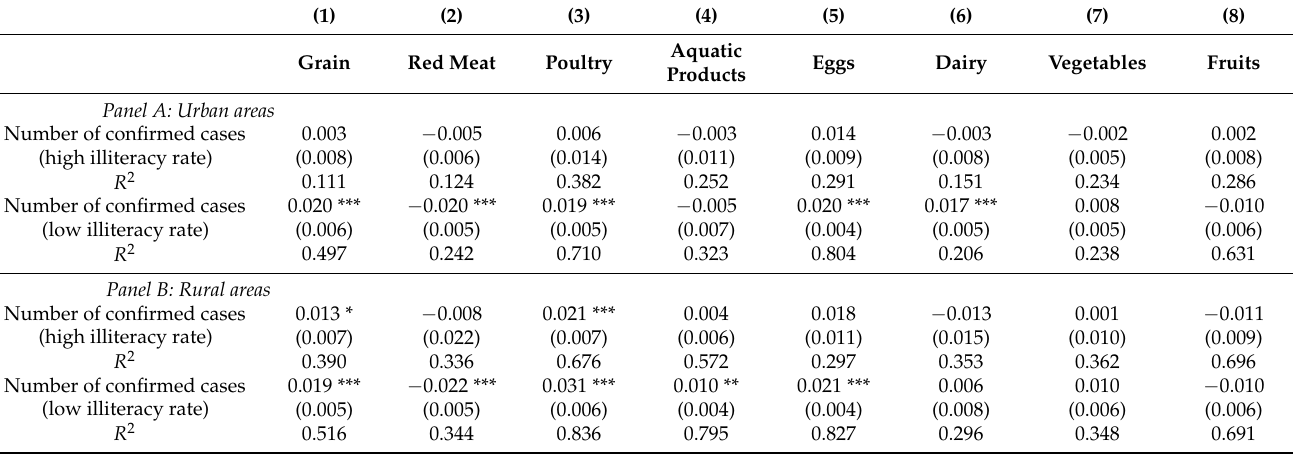
Table 5. Impacts of COVID-19 on urban and rural dietary consumption: heterogeneity by illiteracy rate.